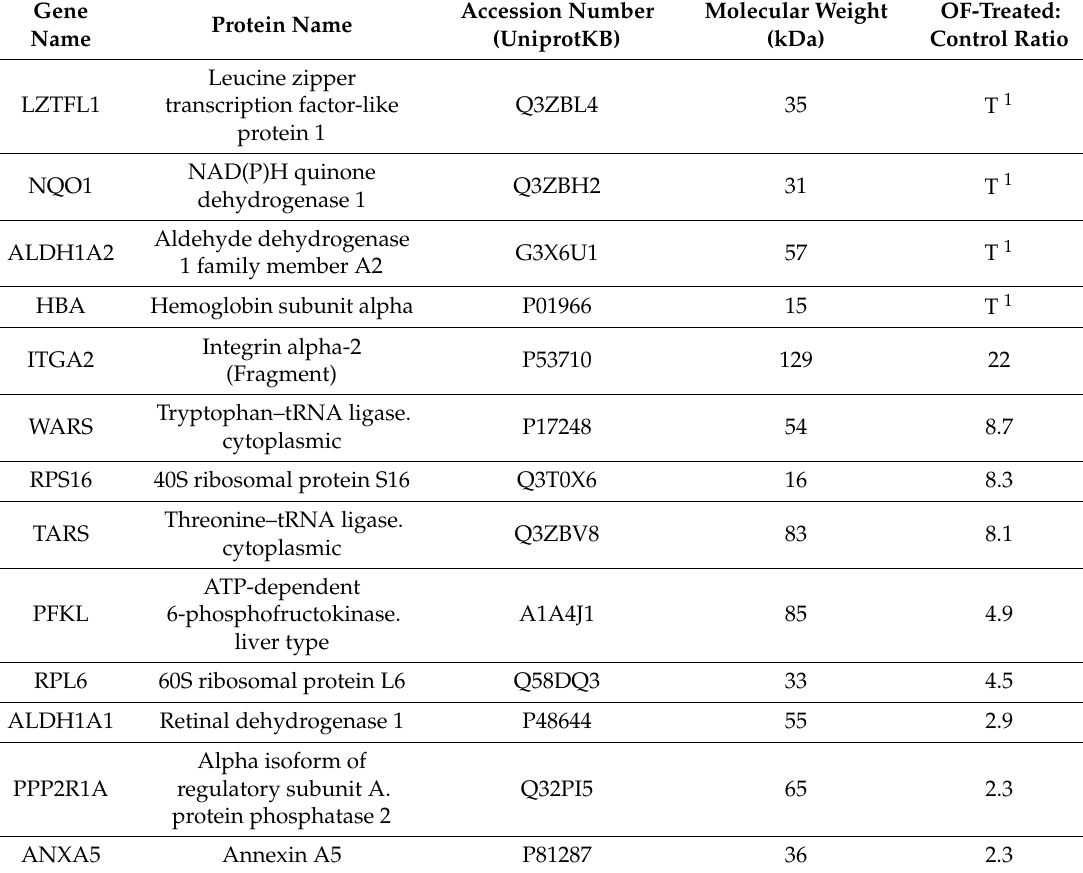
Table 1. Proteins identified as interacting with embryos at the 4–6 cell stage.